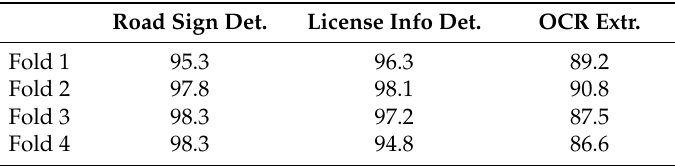
Table 2. Results for the Probabilistic Score of the three modules. Road Sign Det. License Info Det. OCR Extr.